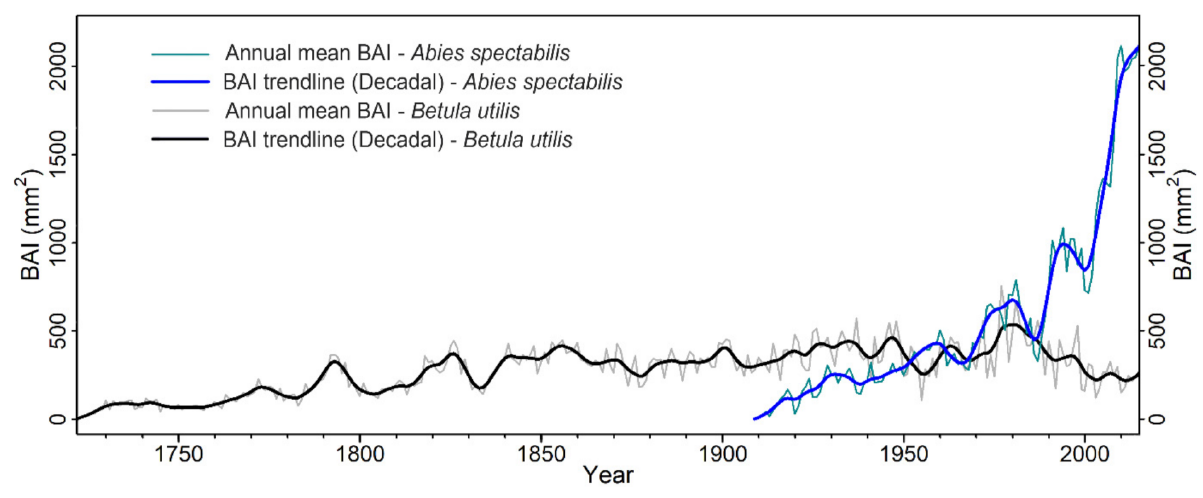
Figure 5. Basal Area Increment (BAI) trend of Abies spectabilis and Betula utilis trees. Blue and black bold lines are 10-year moving average of BAI for Abies spectabilis and Betula utilis ,